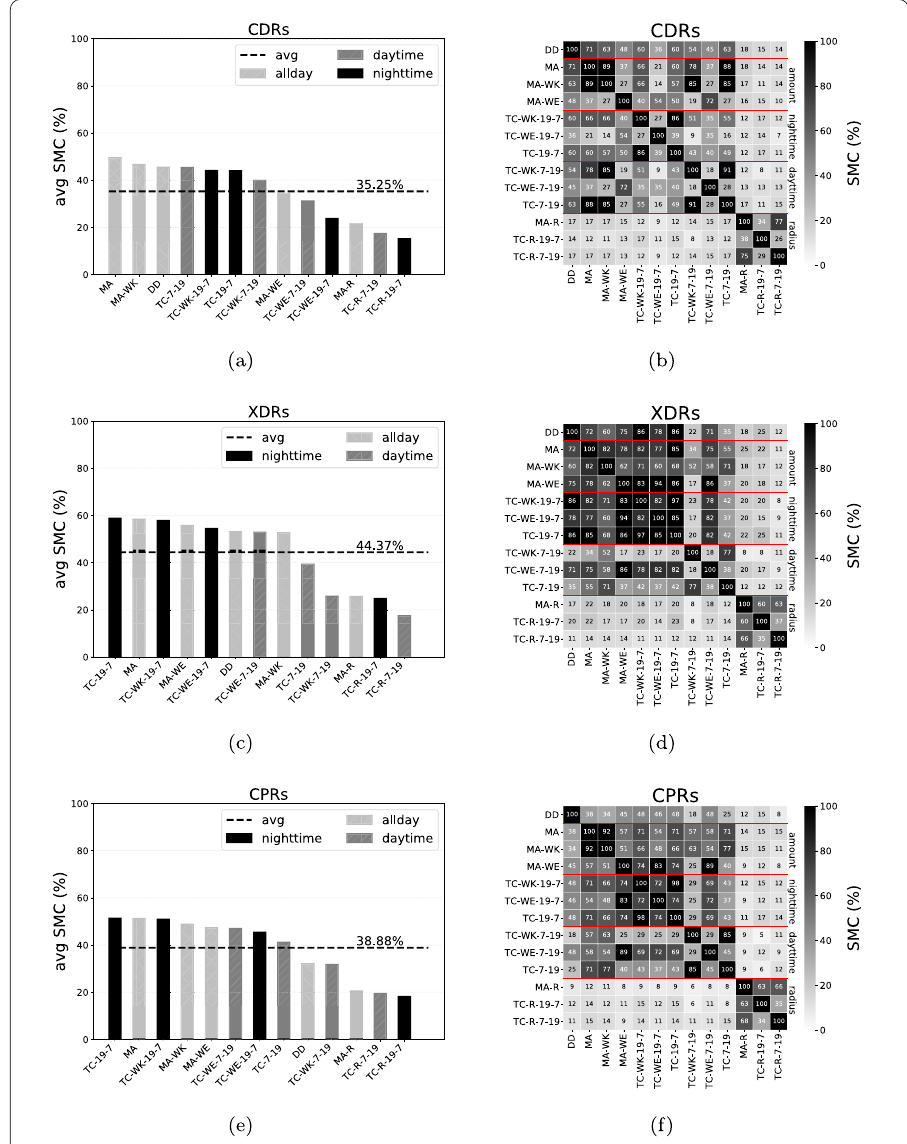
Figure 4 ( a ), ( b ), ( e ) The SMC of each pair of HDAs, for each stream. The black dashed line indicates the average SMC of a stream. ( b ), ( d ), ( f ) SMC between each pair of HDAs (elements of the matrix), for each